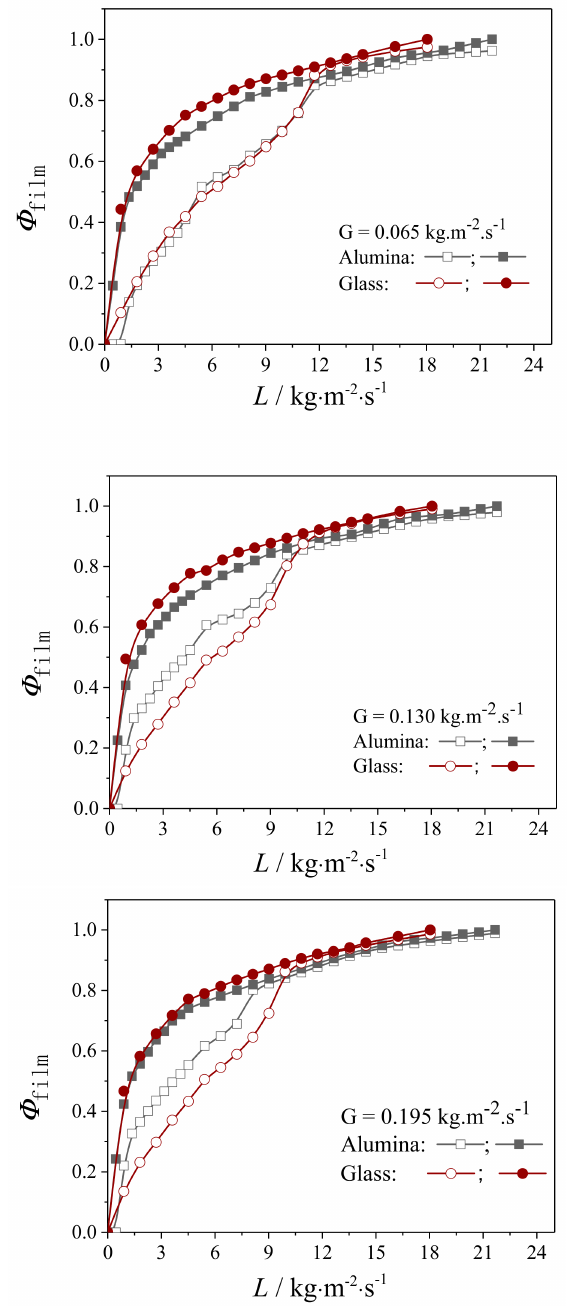
Figure 5. Fraction of film flow over the packing